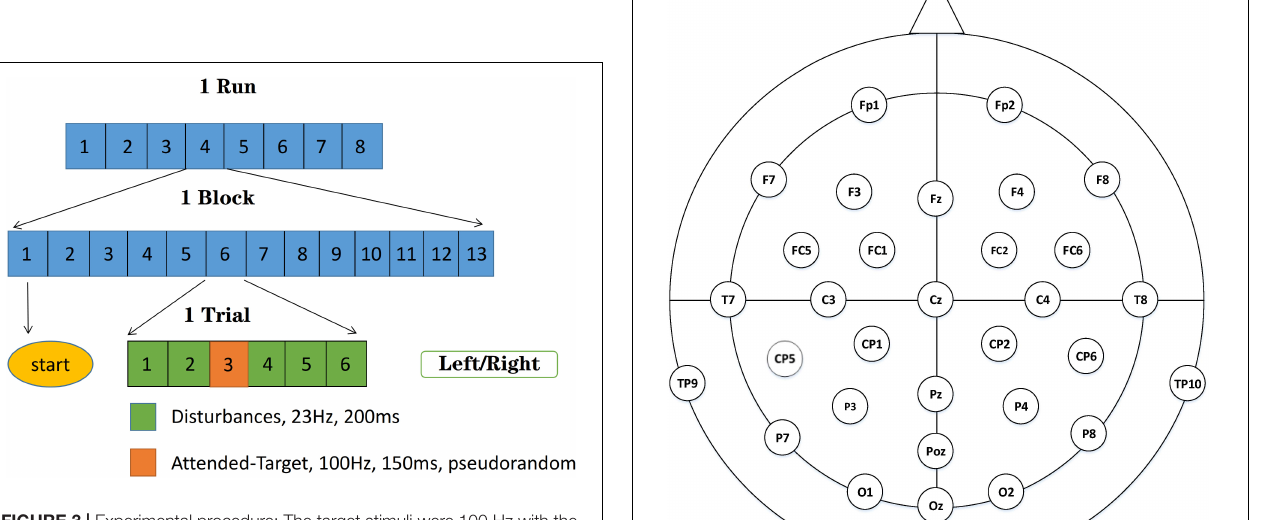
each target stimulus onset was extracted, with the baseline of 200 ms before onset. Independent component analysis (ICA) was conducted to remove EOG (Electrooculogram) signals, for example, components that distribute mostly in the prefrontal region, and components that distribute symmetrically, both with high energy in the low-frequency bands.